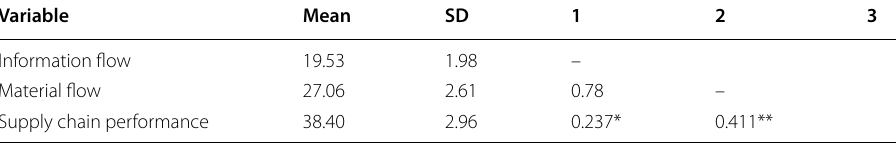
* significant positive relationship (information flow & supply chain)